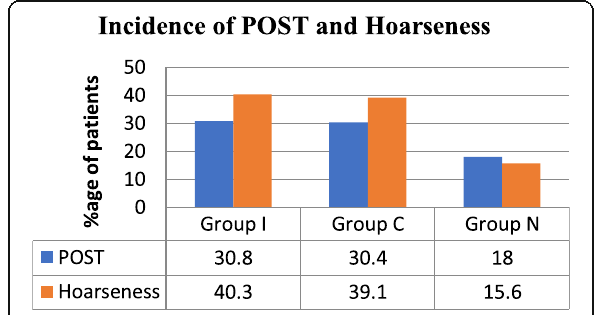
Fig. 1 Incidence of POST and hoarseness after 24 h